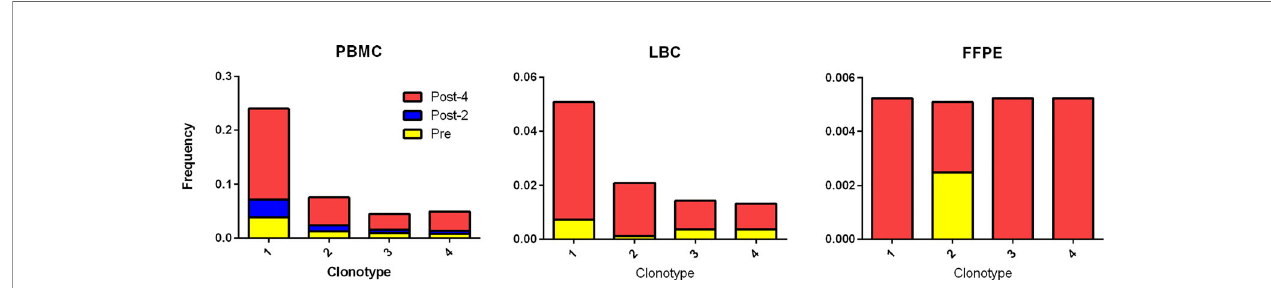
FIGURE 5 | Tracking HPV 16 E6 91-115 speci fi c T cells in PBMC, LBC, and FFPE. The TCR V a and V b sequences of HPV 16 E6 91-115 speci fi c T cells were determined by sorting and sequencing such cells based on IFN- g secretion upon peptide stimulation. The TCR V b CDR3 sequences of top 4 clonotypes ( ≥ 5% of IFN- g secreting cells) are shown in Table 3 . The frequencies of these clonotypes in PBMC, LBC, and FFPE at pre-vaccination (yellow), post-2 vaccinations (blue), and post-4 vaccinations (red) time points are shown. All 4 vaccine-speci fi c clonotypes in PBMC and LBC increased in frequency after 4 vaccinations. On the other hand, data from FFPE were not